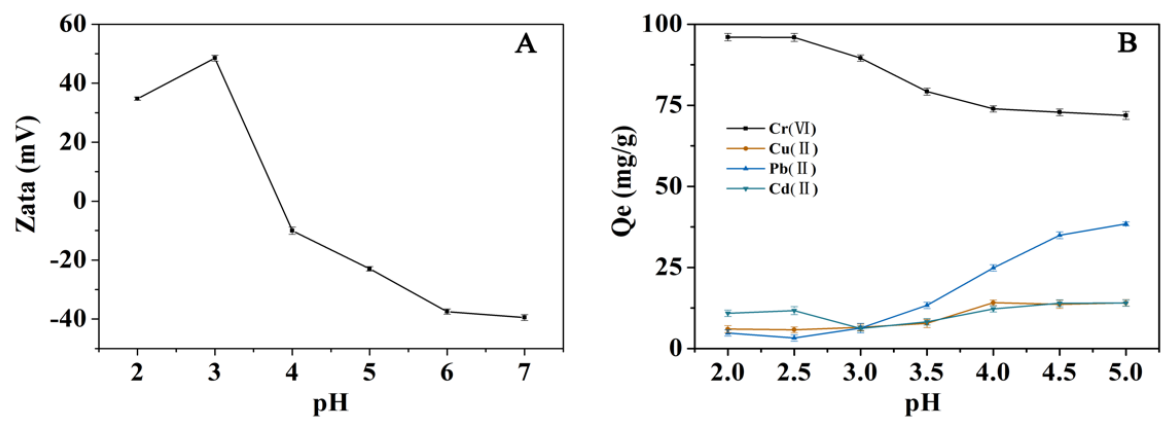
adsorption capacity of Cr(VI), Cu(II), 2 ; stirring: 400 rpm; ℃